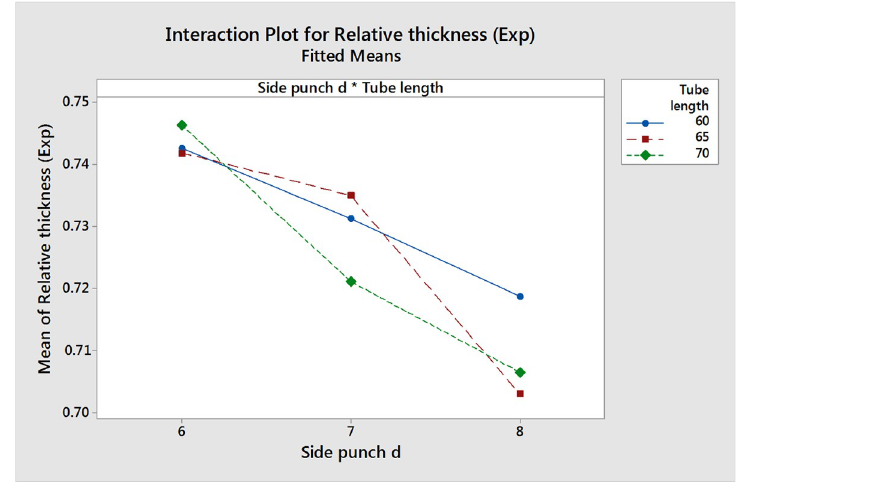
Fig 18. Normality test plot for RT.